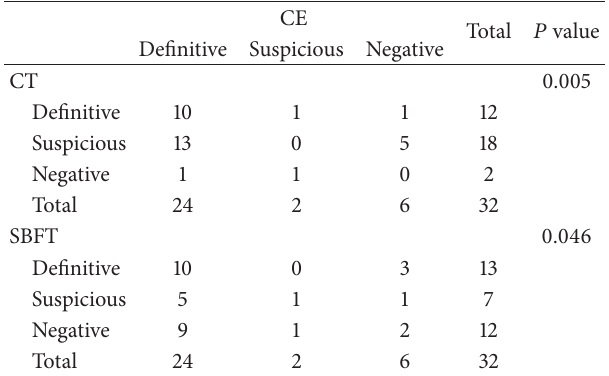
Table 5: Comparisons of sensitivities of three modalities for small bowel